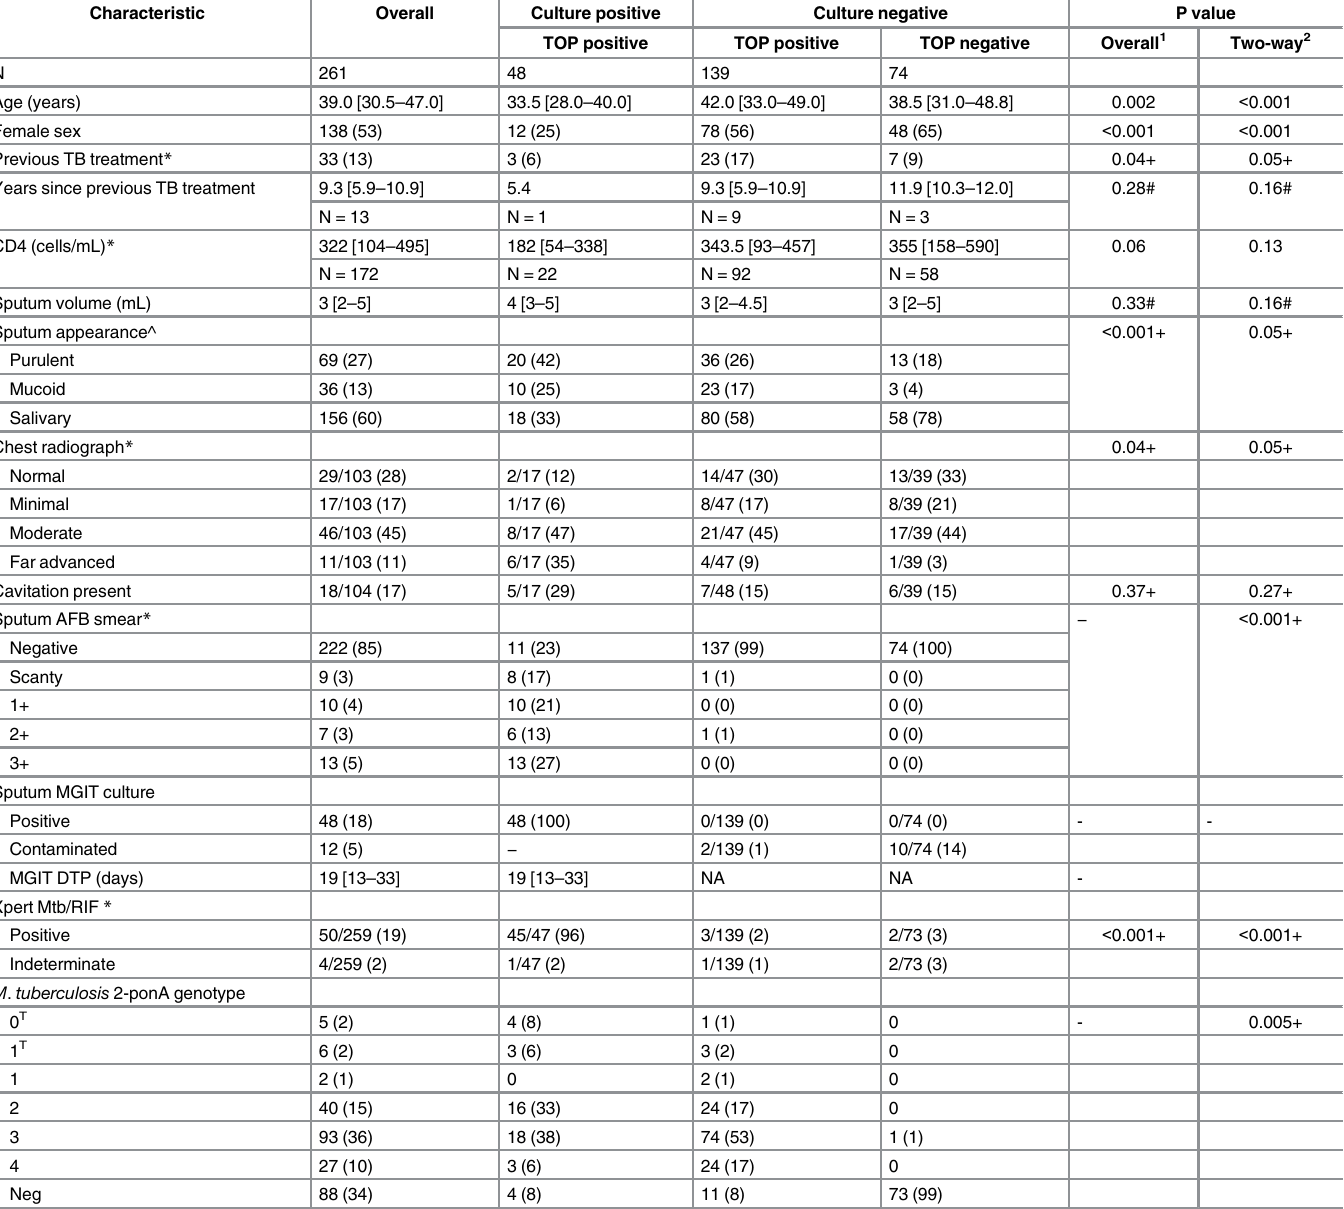
Table 1. Characteristics of 261 HIV-infected pulmonary tuberculosis suspects in Mbarara, Uganda by M . tuberculosis culture and TOP TB assay results. Characteristic Overall Culture positive Culture negative P value TOP positive TOP positive TOP negative Overall